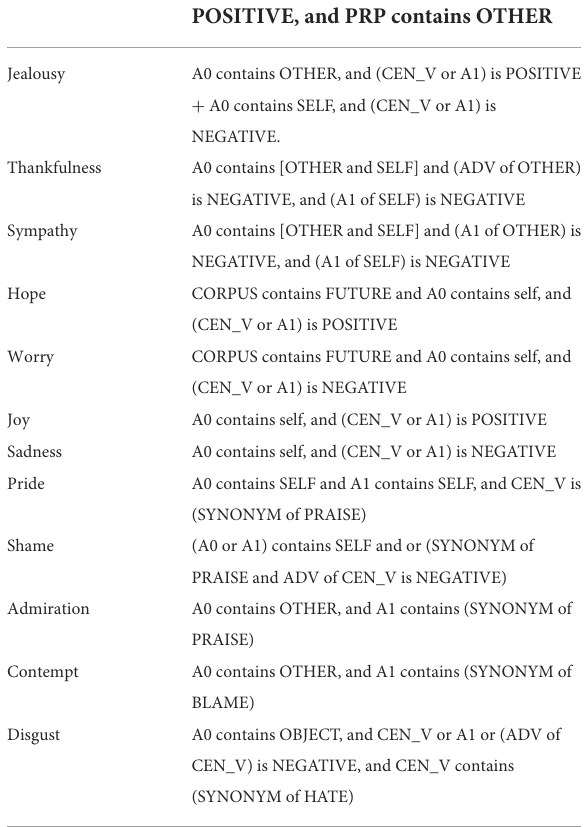
TABLE 3 Rules of 13 types of emotion